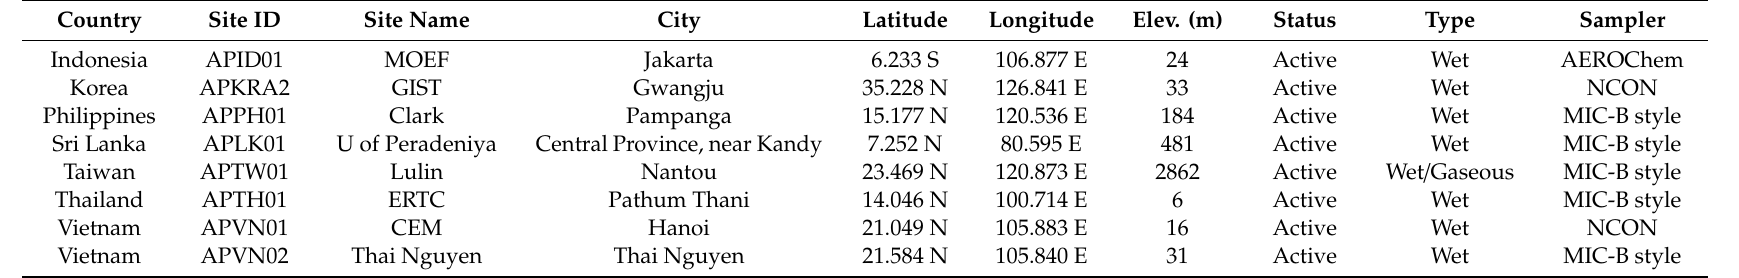
Table 1. Monitoring site information for Asia Pacific Mercury Monitoring Network sites, as of